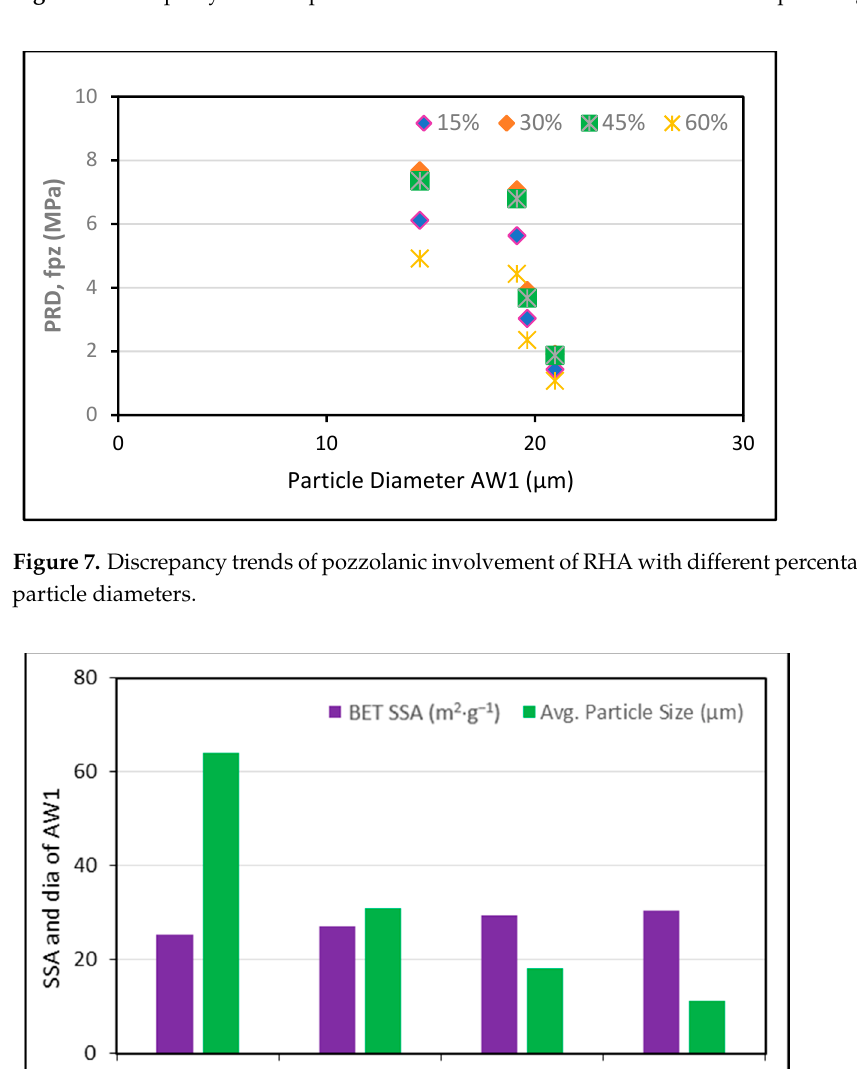
Figure 6. Discrepancy trends of pozzolanic reactions of RHA with BET SSA and the percentage of additives.